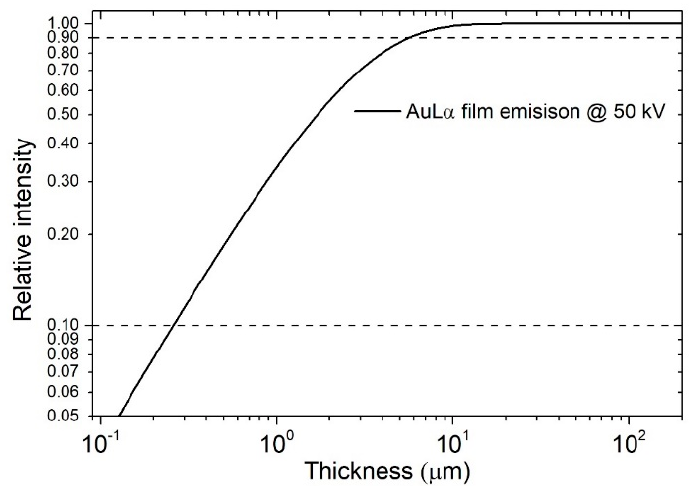
Figure 13. Log–log plot of the emission of Au film on Cu as a function of the thickness using a 50 kV X-ray beam. The 10%–90% thickness range is marked.